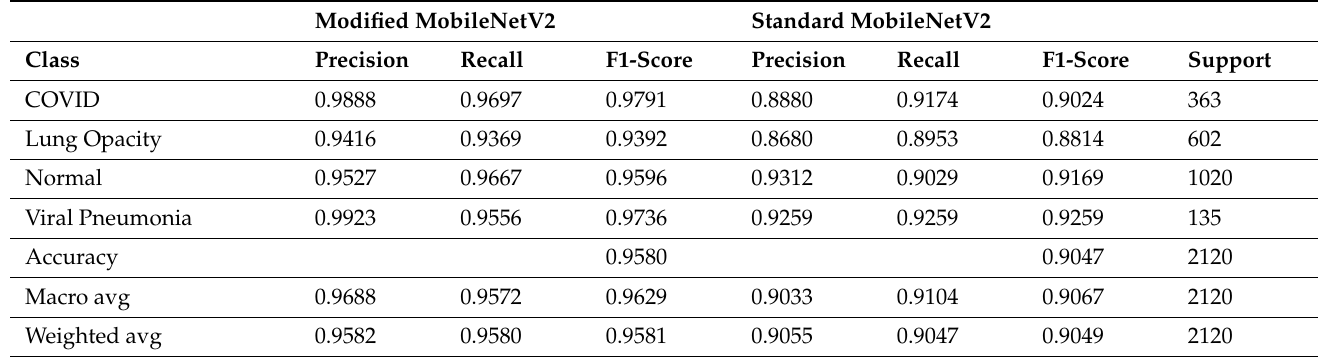
Table 4. Comparison of classification report of standard MobileNetV2 and modified MobileNetV2 for 4 classes (COVID-19, normal, viral pneumonia and lung opacity) classification.